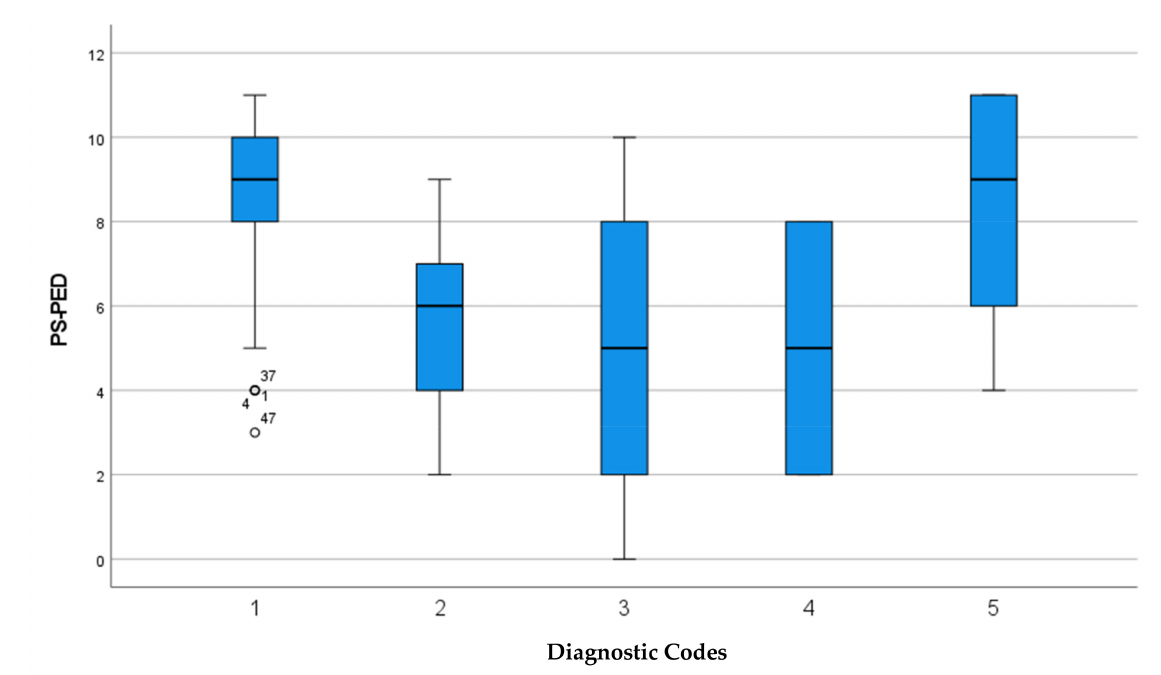
Figure 3. Differences in PS-PED score across different diagnostic groups. 1—Neurological and neu- romuscular conditions; 2—Structural anomalies of the digestive and respiratory systems; 3—Others, 4—Cardiac disorders; 5—Genetic